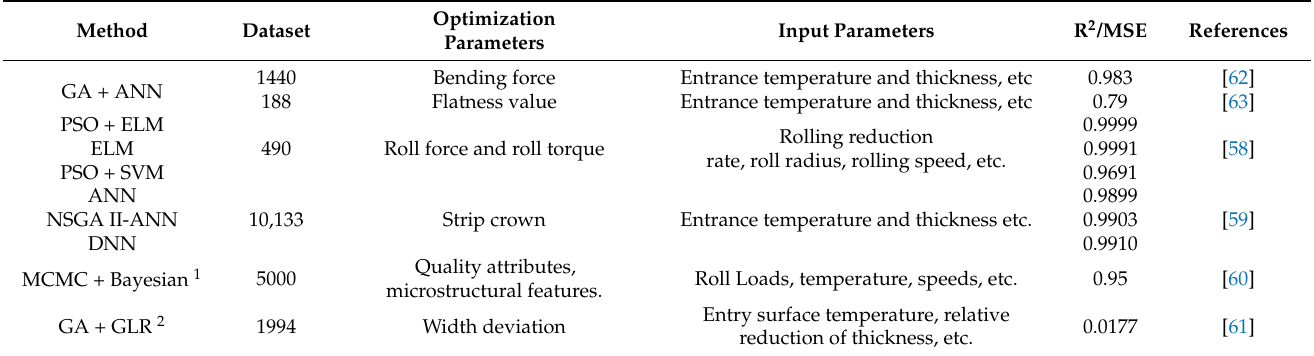
Table 4. A summary of intelligent optimization methods for